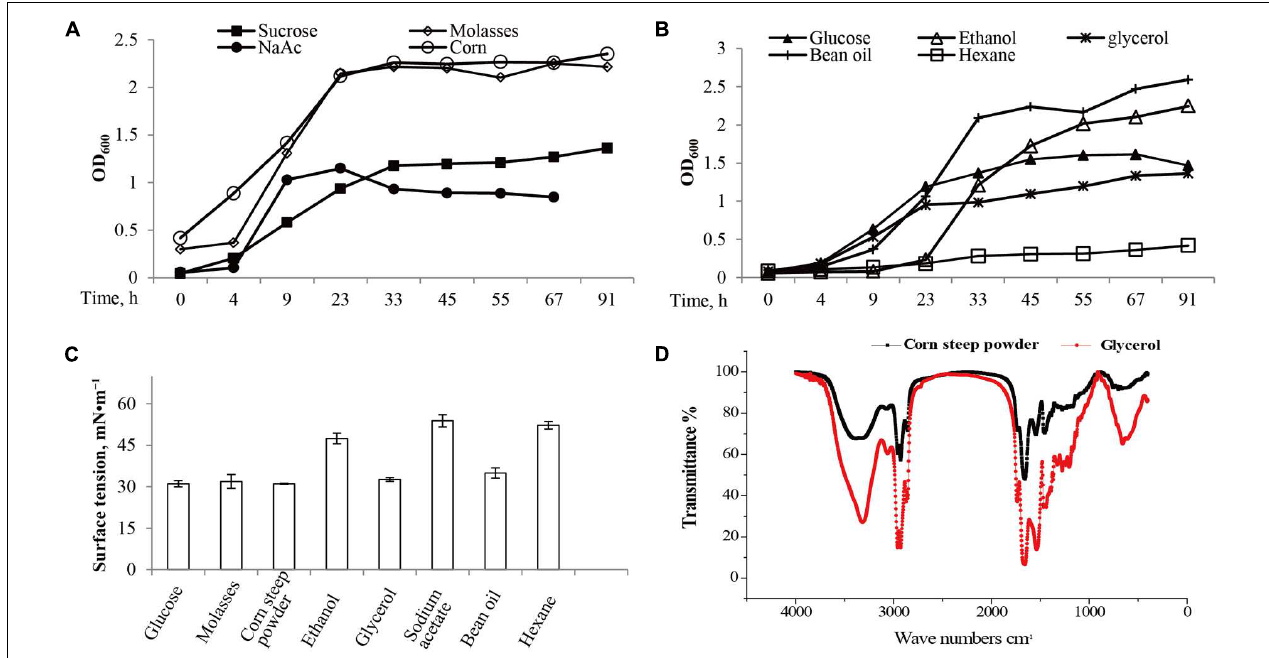
FIGURE 3 | Microbial growth and surfactant production of Bacillus subtilis M15-10-1 when grown with diverse carbon sources. The growth curves are measured by (A,B) optical density (OD 600 ), (C) the pH and surface tension of fermentation broth, and (D) the Fourier transform infrared spectrometry (FTIR) spectra of